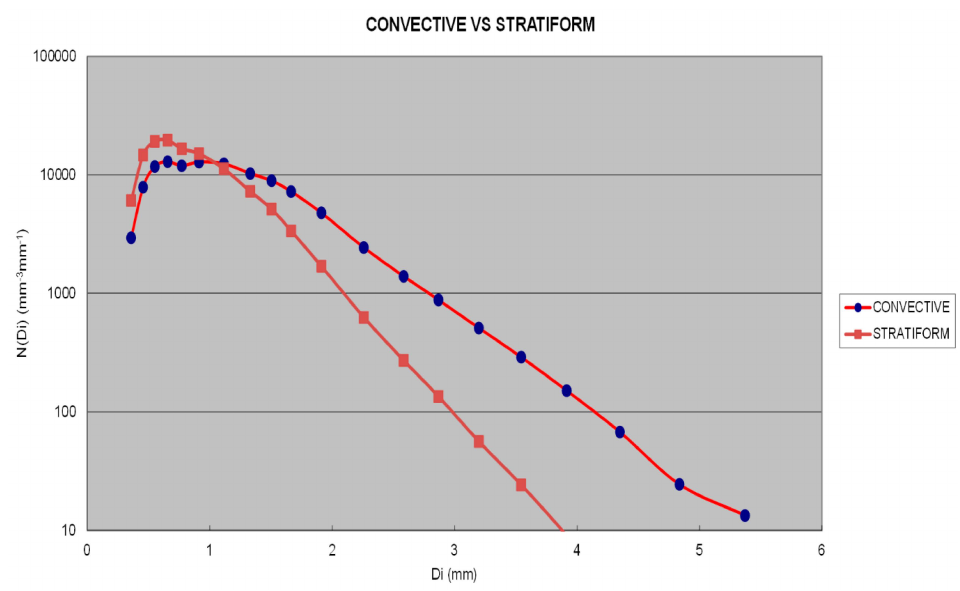
Figure 2. Representative curve N(D) for each rainfall type (convective and stratiform).